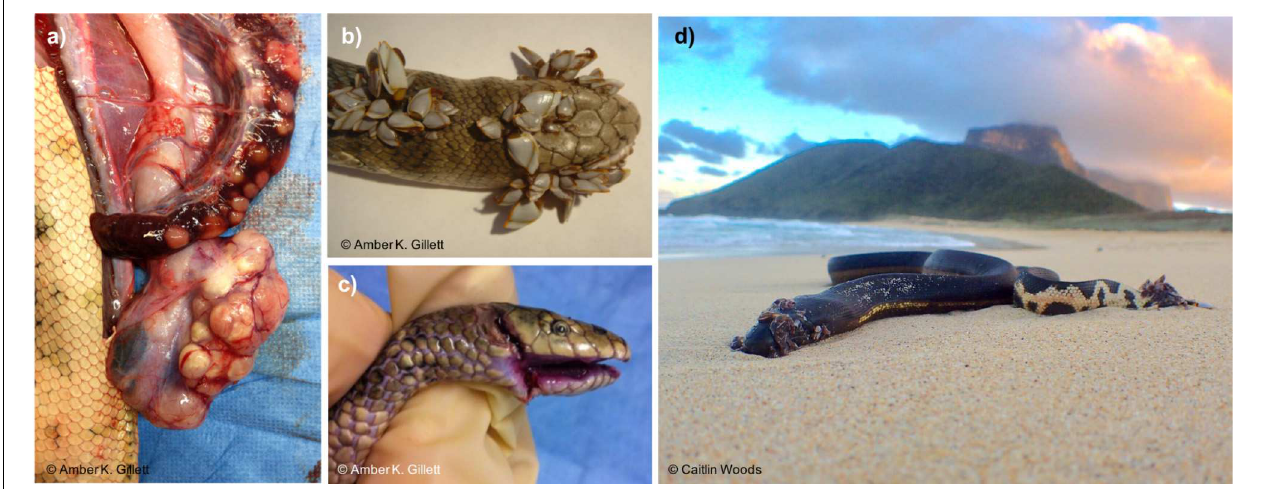
FIGURE 5 | Disease and strandings of marine snakes; (a) stranded Hydrophis elegans found with neoplastic masses through the liver and splenopancreas consistent with adenocarcinoma; (b) beach-washed H. major that presented with seizures and head twitching, and heavily parasitized with Lepas ansifera barnacles; (c) linear wound to the head of a H. elegans from presumed boat strike; and (d) stranded pelagic sea snake ( H. platurus ) with heavy biofouling. Images provided with permission to use from Amber K. Gillett and Caitlin